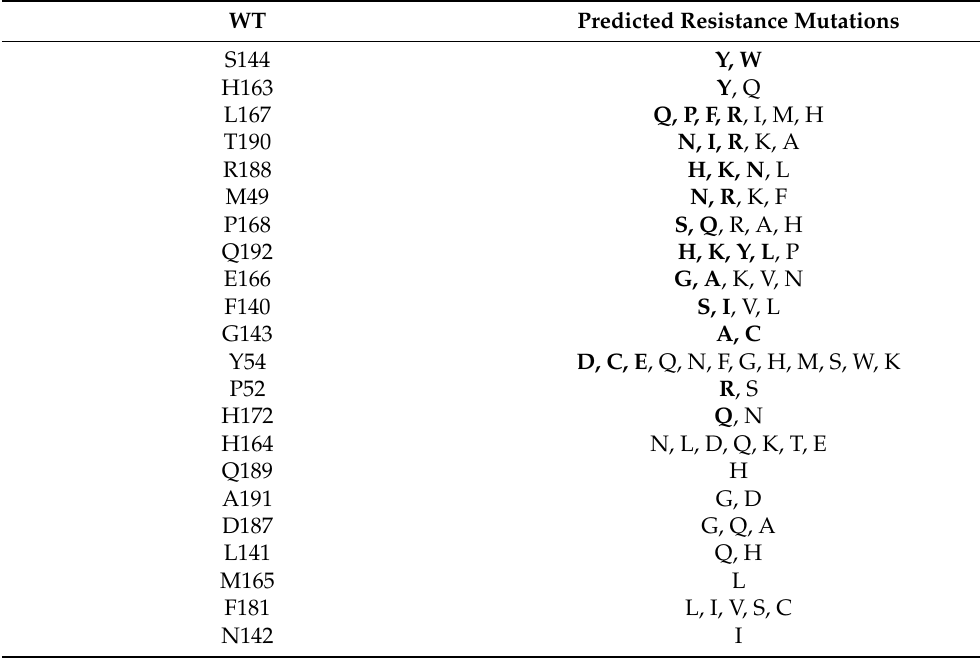
Table 4. List of predicted resistance mutations in SARS-CoV-2 3CLpro for nirmatrelvir.